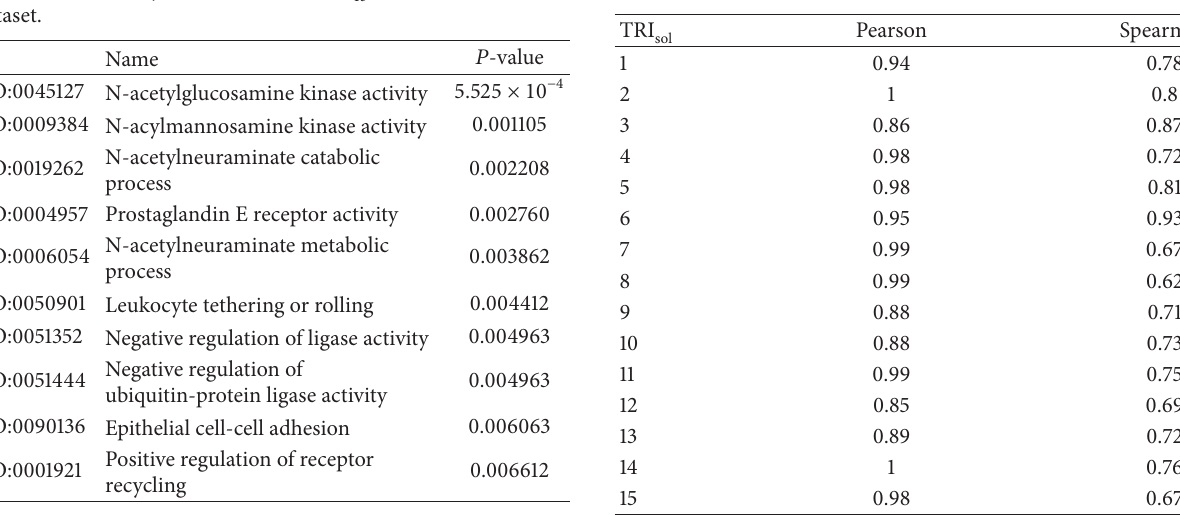
Table 13: Correlation results for Human GDS4472